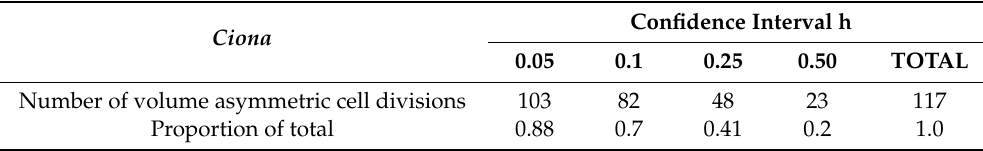
Table 1. Number and proportion of cell divisions above confidence interval threshold (see Methods) for asymmetric cell divisions, based on Equation (2). Data represents all divisions (N = 117) in a pre-gastrulation Ciona fate lineage